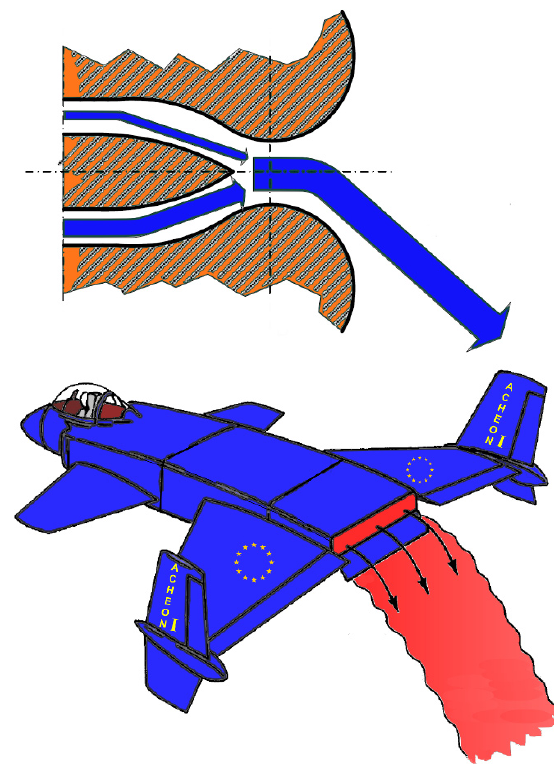
Figure 5. The HOMER nozzle comprising two main streams that, when in differential mass flow operation, will cause the thrust vectoring of the nozzle. The system can be incorpo- rated on an airplane to achieve STOL, or even eventually VTOL for alternative